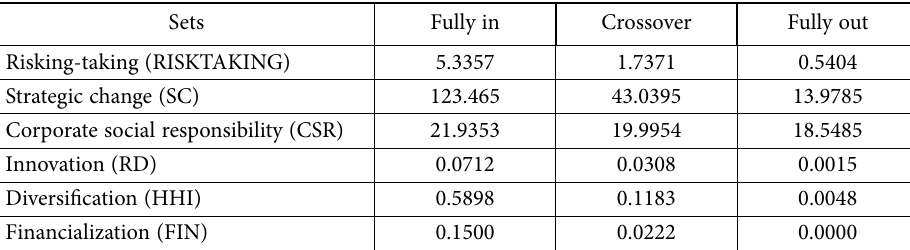
Table 1. Calibration for outcome and conditions Sets Fully in Risking-taking